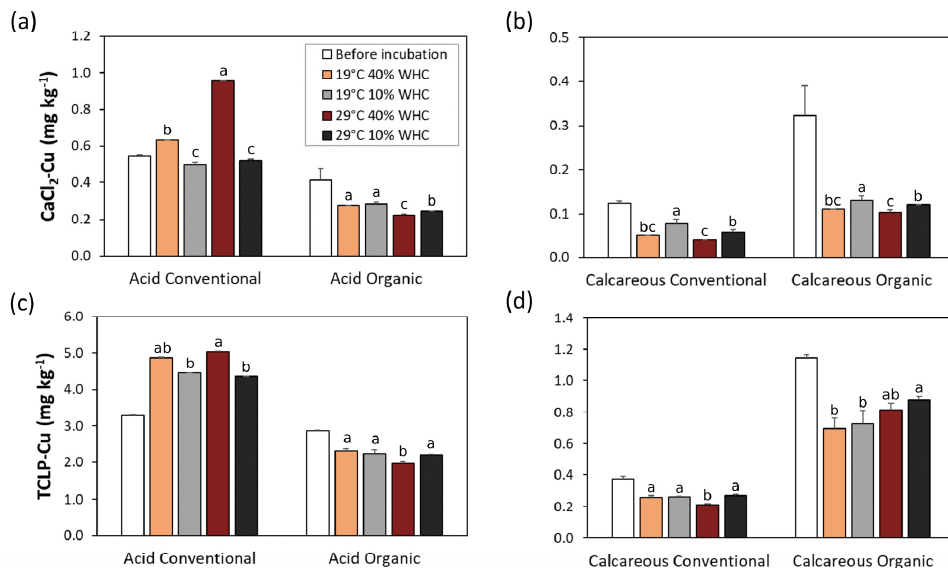
Figure 3. Bioavailability ( a , b ) and leaching ( c , d ) of Cu in soils before and after 6 months’ incubation under no stress (19 ◦ C and 40% WHC), moisture (19 ◦ C and 10% WHC), temperature (29 ◦ C and 40% WHC), and combined stresses (29 ◦ C and 10% WHC). Different letters denote significant differences between treatments within each soil type and management, according to Tukey’s multiple comparison test ( p < 0.05).